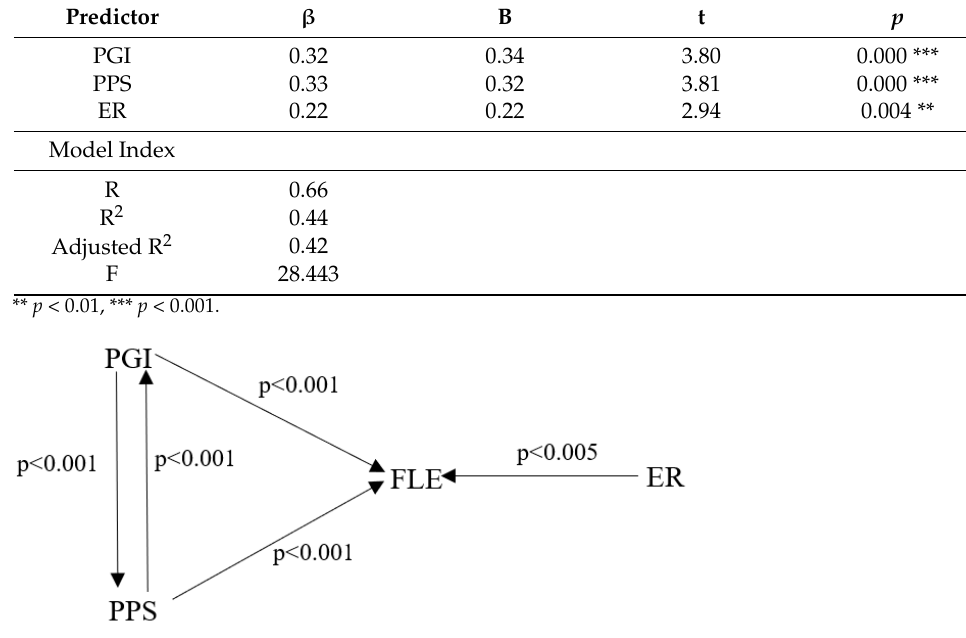
Figure 5. Regression model of university EFL students’ FLE.